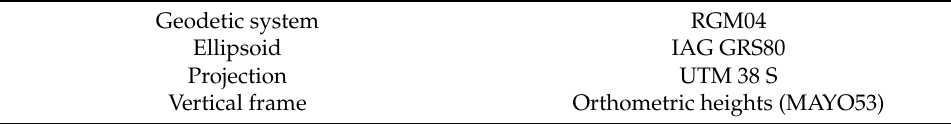
Table 1. Specifications of the Litto3D ® dataset acquired over